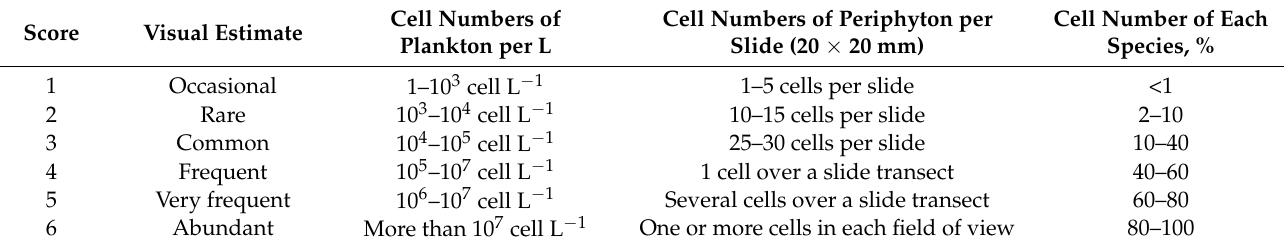
Table 2. Species frequencies scale according to